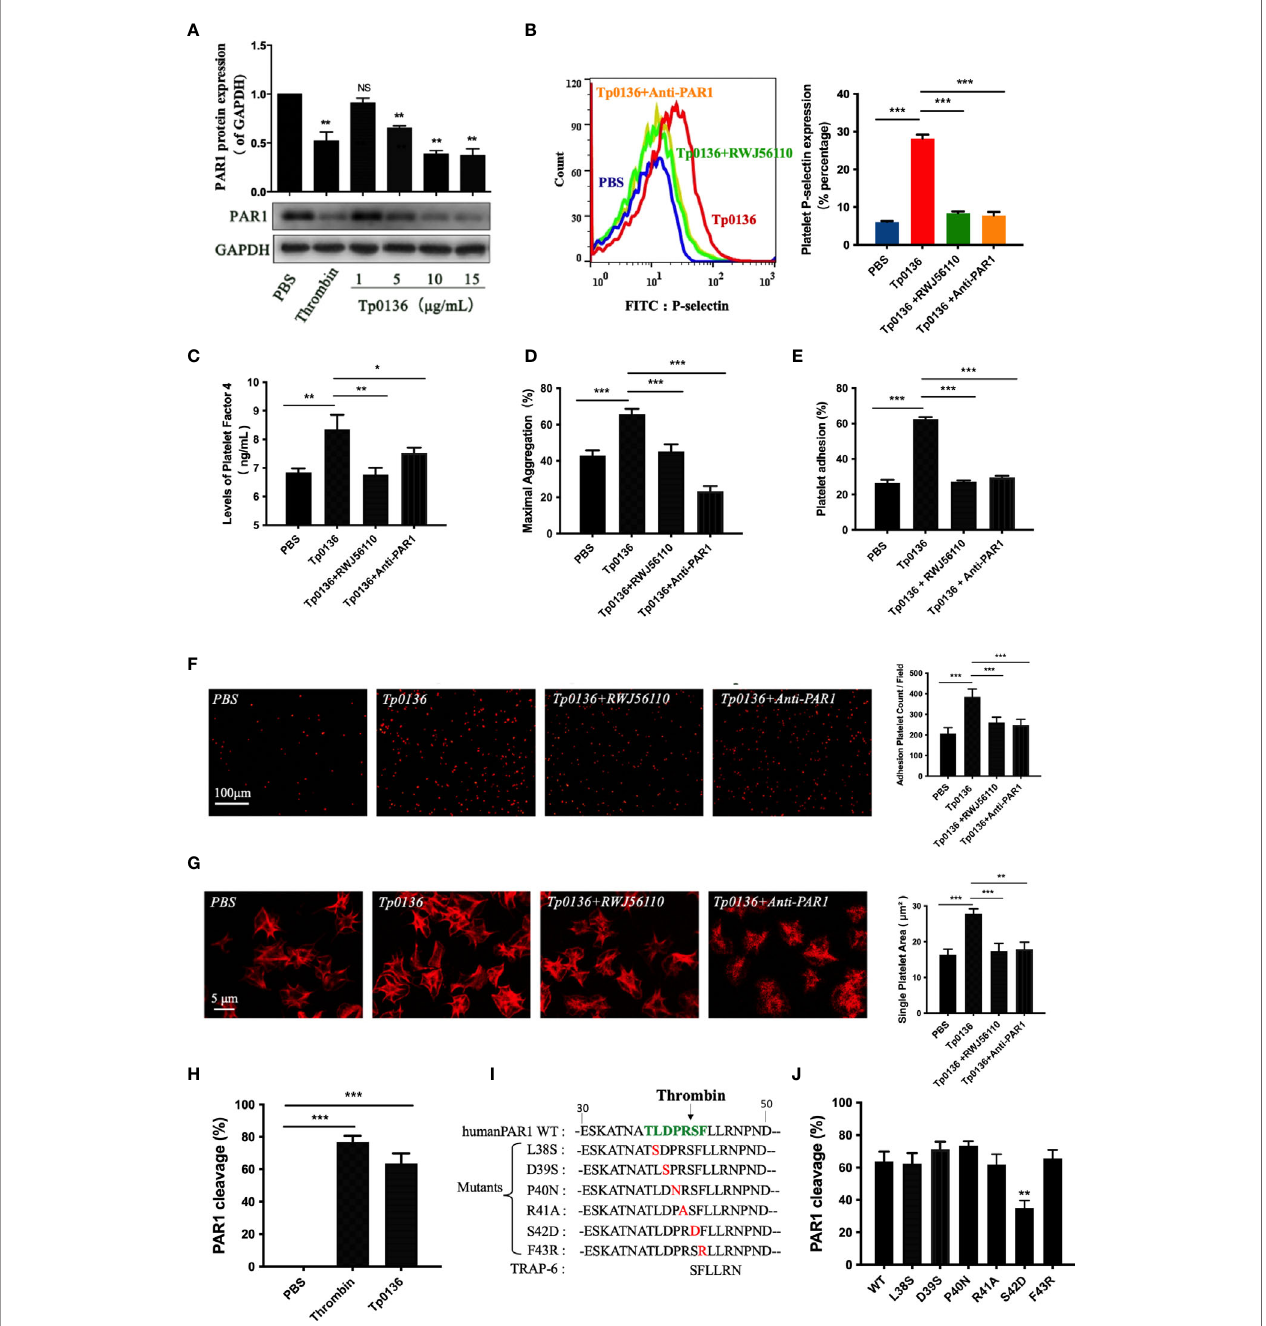
FIGURE 3 | Tp0136 promoted platelet activation and aggregation through PAR1. (A) PAR1 protein expression as determined by western blotting. (B-G) Effects of the PAR1 antagonist RWJ56110 and the anti-PAR1 antibody on platelet activation and aggregation induced by Tp0136. (B) P-selectin expression as measured by fl ow cytometry. (C) PF4 expression as measured by ELISA. (D) Maximal platelet aggregation as determined by an aggregometer. (E) Platelet adhesion as assessed by ELISA. (F,G) Platelet adhesion as assessed by staining with TRITC-labeled phalloidin. Statistical data are based on the number of platelet adhesions (F) and were calculated from the mean of the average surface area of individual platelets (G) . (H) Effect of Tp0136 on PAR1 as determined by fl ow cytometry. (I) Amino acid sequences of WT (wild-type) PAR1, PAR1 proteins with mutations in the extracellular domain and a PAR1 peptide agonist (TRAP-6). (J) Exploration of the Tp0136 protein sites that act on PAR1. The values are presented as the mean ± SEM of experimental triplicates and are representative of the results of three independent experiments. Values among multiple groups were compared by one-way ANOVA. Comparisons between two groups were made using a paired t-test (NS, no signi fi cance, * P < 0.05, ** P < 0.01, *** P <